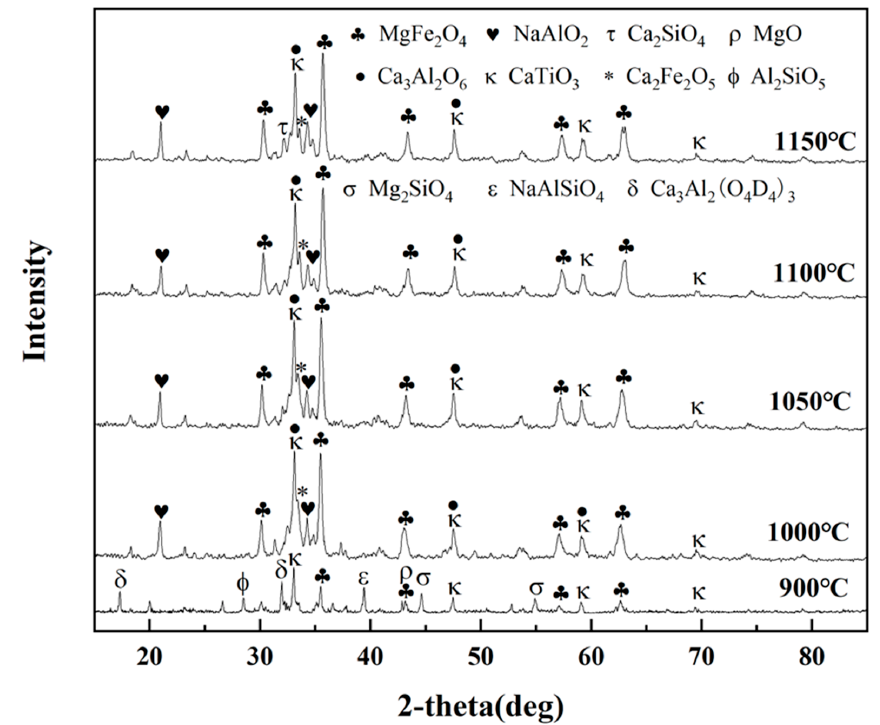
Figure 8. XRD pa tt erns of the sintered red mud at di ff erent sintering temperatures. Figure 8. XRD patterns of the sintered red mud at different sintering